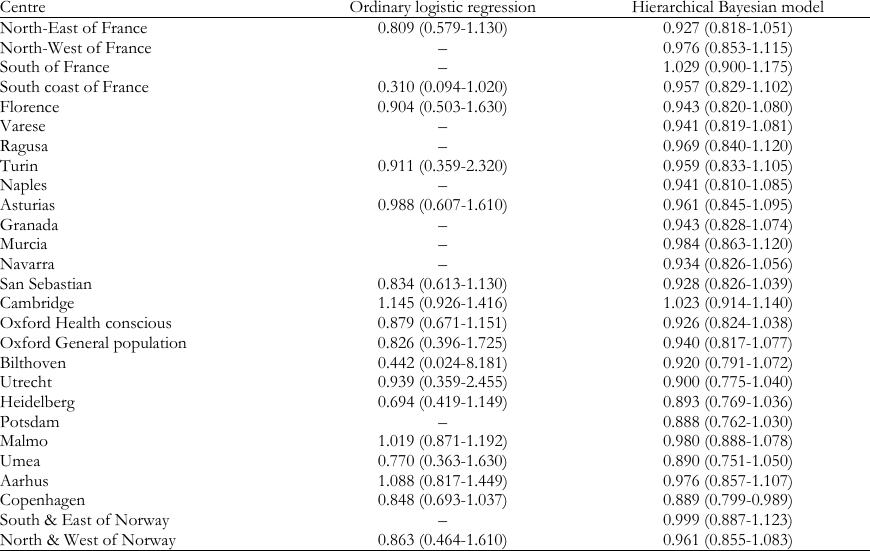
Estimated ORs (95% CI) by centre: